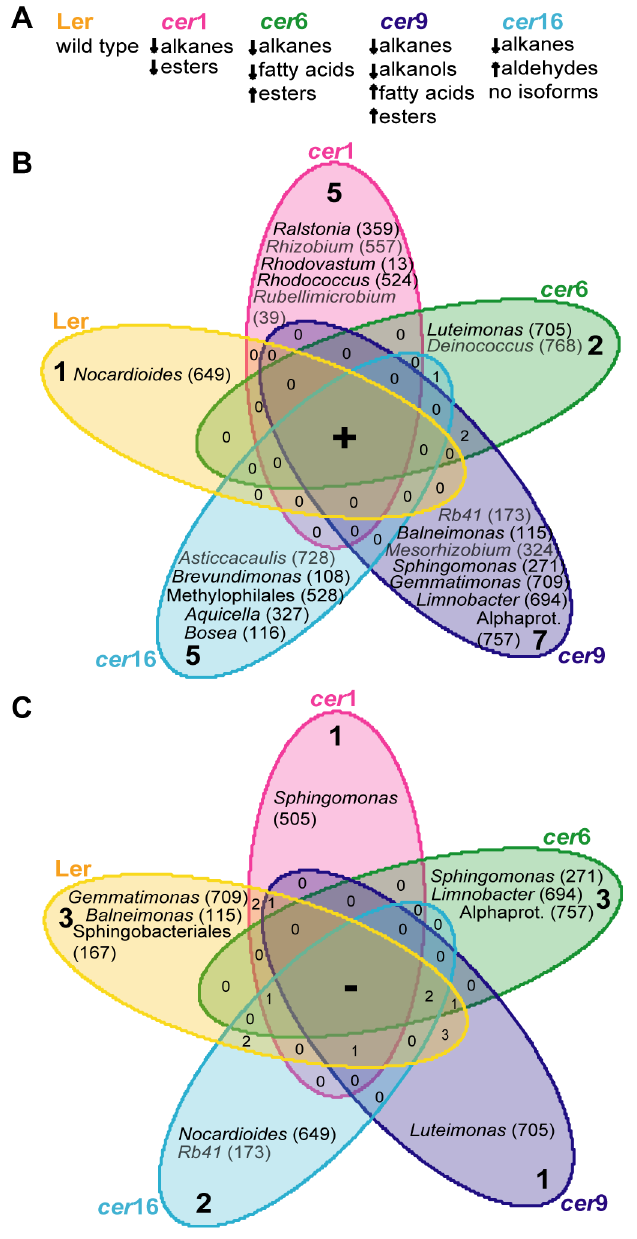
Figure 6. Venn diagram of the plant-line specific communities. Counts of uniquely present (Fig. 6A) or uniquely absent (Fig. 6B) phylotypes are shown. OTUs that were present or absent on multiple plant lines are indicated by numbers in the overlapping areas of the diagram. Grey writing indicates phylotypes, which were represented by sequence abundances below 1% of the plant line-specific communities. The plant line-specific community data was extracted from a rarified dataset and only those OTUs were included that were found non–chimeric with both (Greengenes and Silva_108) reference datasets. The closest possible taxonomic affiliation is given. OTU numbers are given in brackets.